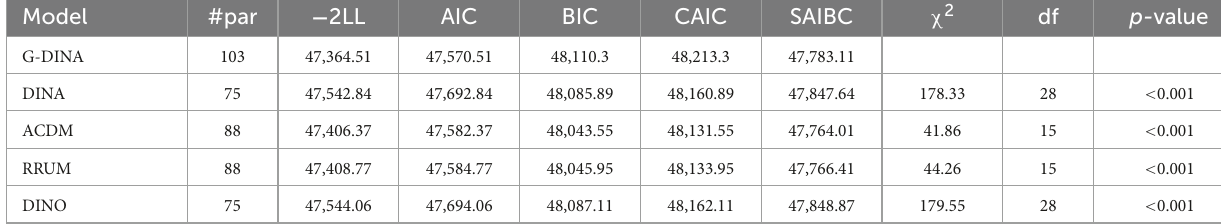
TABLE 4 Summary of model-data fit.